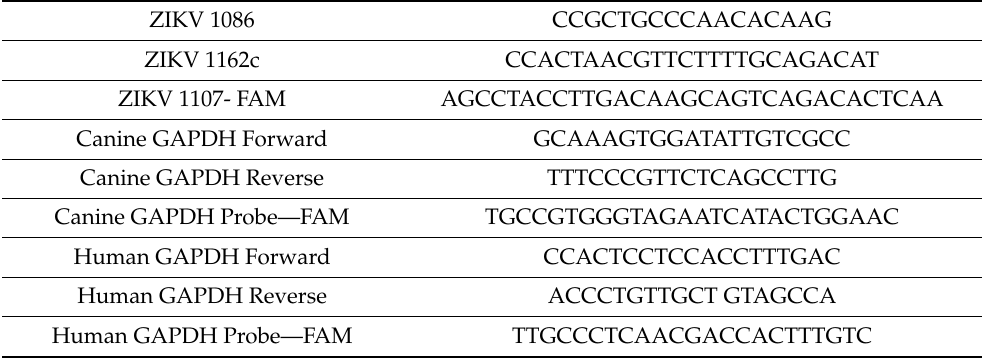
Table 1. Primers for RT